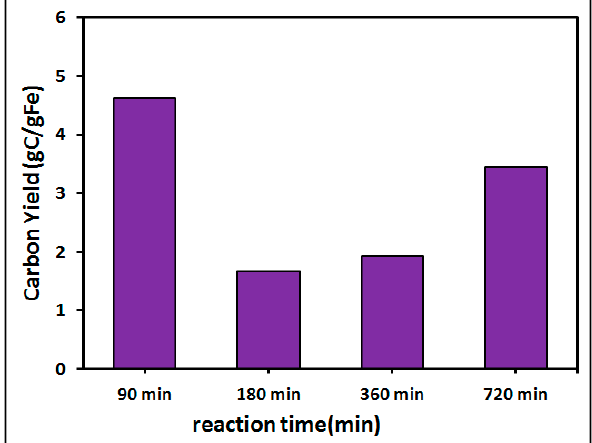
Figure 8. Carbon yields obtained after 90, 180, 360, and 720 min of reaction.